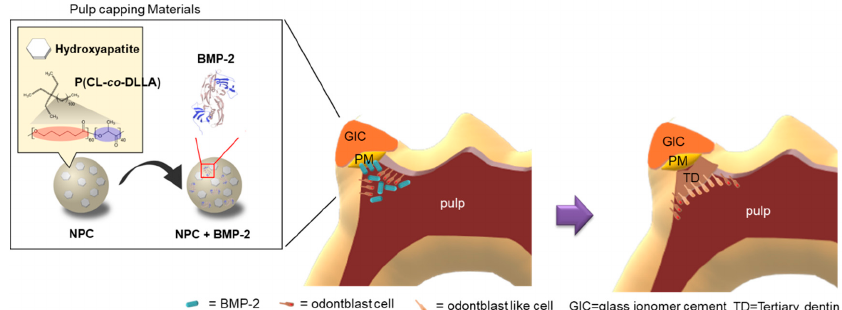
Figure 7. Proposed model for the NPC with BMP-2 effect on the wound healing of pulp tissue. After